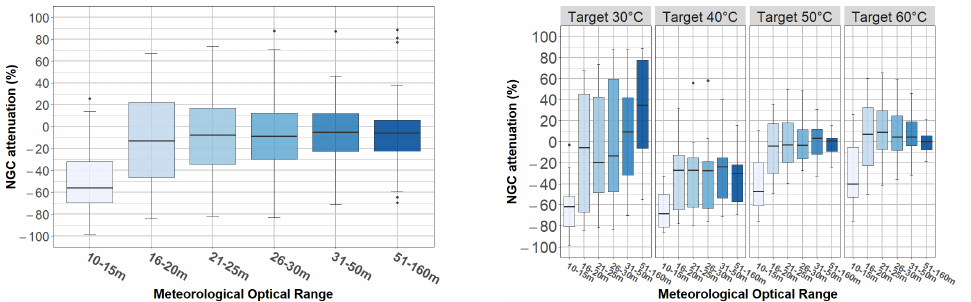
Figure 19. NGC attenuation per MOR and targets.